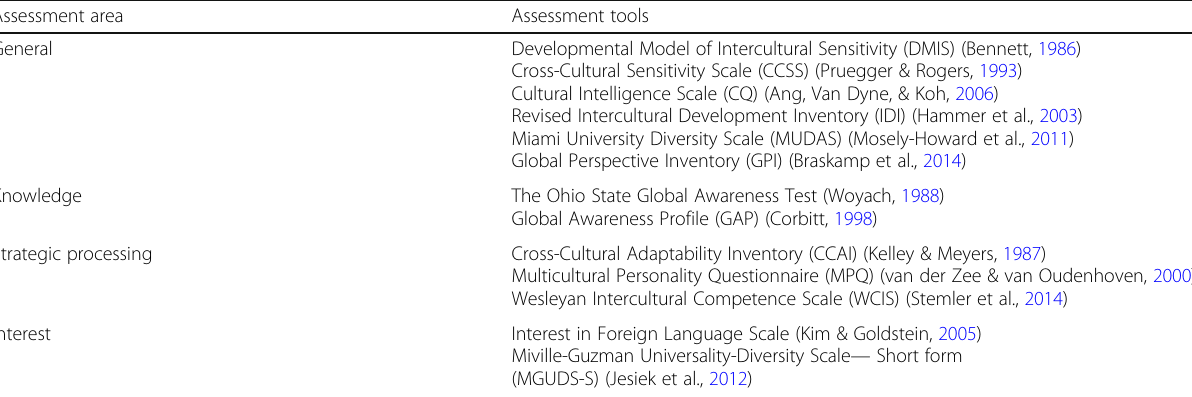
Table 2 Previous assessments for global awareness Assessment